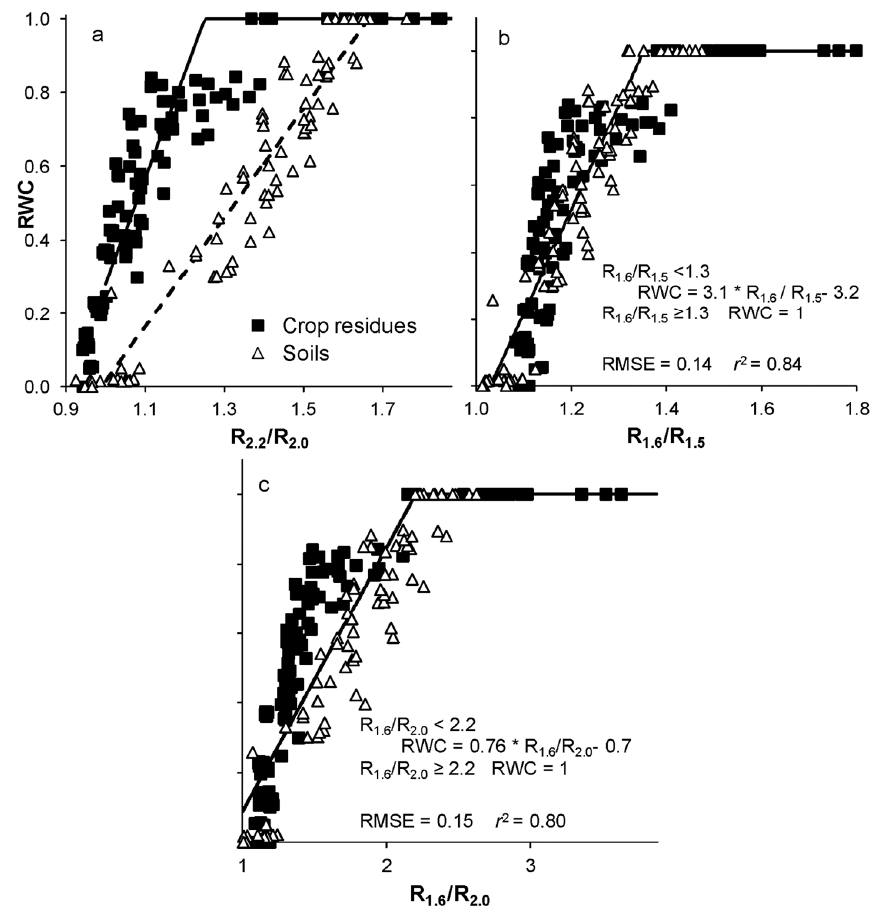
Figure 6. RWC for crop residues and soils as a function of three narrow band reflectance ratios: ( a ) R 2.2 /R 2.0 ; ( b ) R 1.6 /R 1.5 ; and ( c ) R 1.6 /R 2.0 . The bands R 1.5 , R 1.6 , R 2.0 and R 2.2 are 10-nm bands centered at 1500, 1600, 2030 and 2200 nm, respectively.